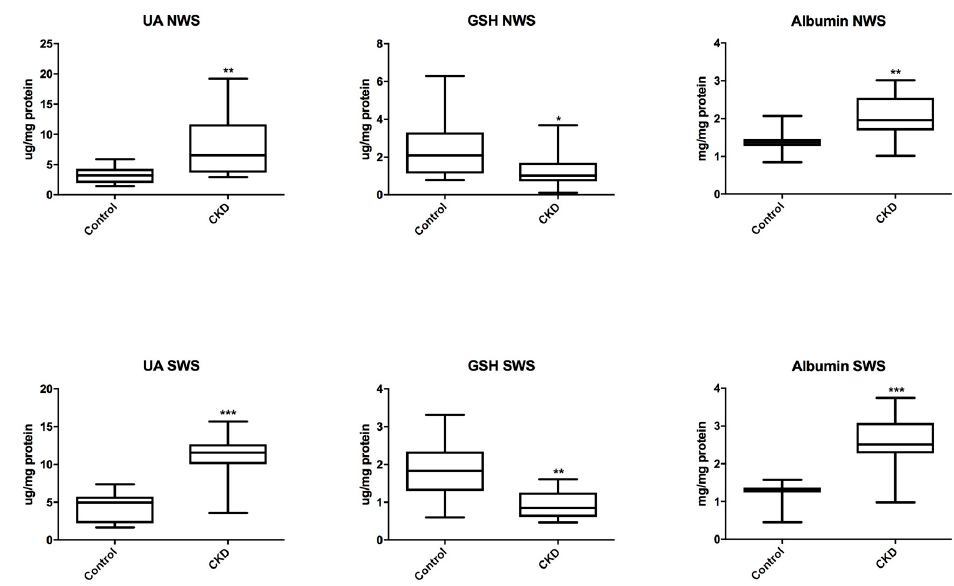
Figure 2. Salivary non-enzymatic antioxidants in children with chronic kidney disease (CKD) and the controls. GSH, reduced glutathione; NWS, non-stimulated whole saliva; SWS, stimulated whole saliva. Differences statistically important at: * P < 0.05, ** P < 0.005, *** P < 0.0005.